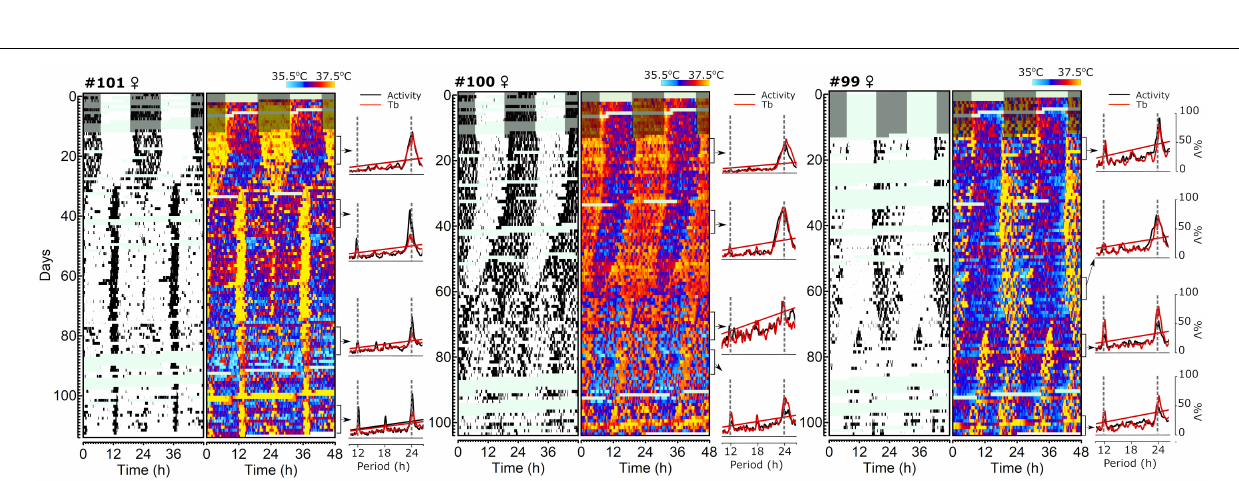
FIGURE 4 | Splitting of wheel running and body temperature rhythms in tuco-tucos under constant light conditions. Three panels depicting data from representative individuals: Animal #101 (left) , Animal #100 (middle) , and Animal #99 (right) . In each panel, the left double-plotted actogram depicts wheel running (black bars indicate when running was recorded) and the actogram to the right depicts body temperature (a color gradient is used to display temperature values, maximum and minimum values are indicated in the legend above the graph). Areas shaded in gray indicate the dark phase of the LD cycle which preceded constant light. Areas shaded in light green indicate missing data. Graphs to the right of actograms depict results of the chi-square periodograms (Sokolove and Bushell, 1978) for wheel running (black) and temperature (red) calculated for the data corresponding to the intervals indicated by the arrows and brackets. Values are shown as spectral power (percentage of variance) as a function of the period tested (5-min steps were used). Inclined lines in the periodograms indicate the significance thresholds ( p < 0.05). 24-h and 12-h periods are emphasized by the dashed vertical gray lines for